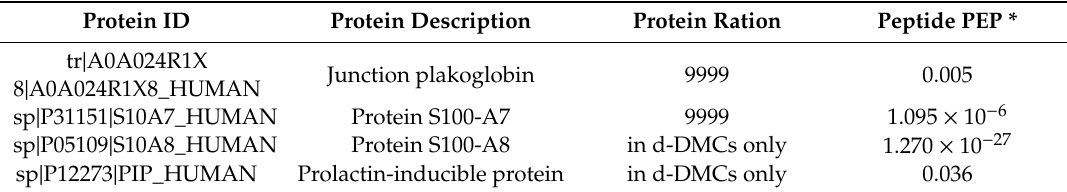
Table 1. Candidates of bioactive